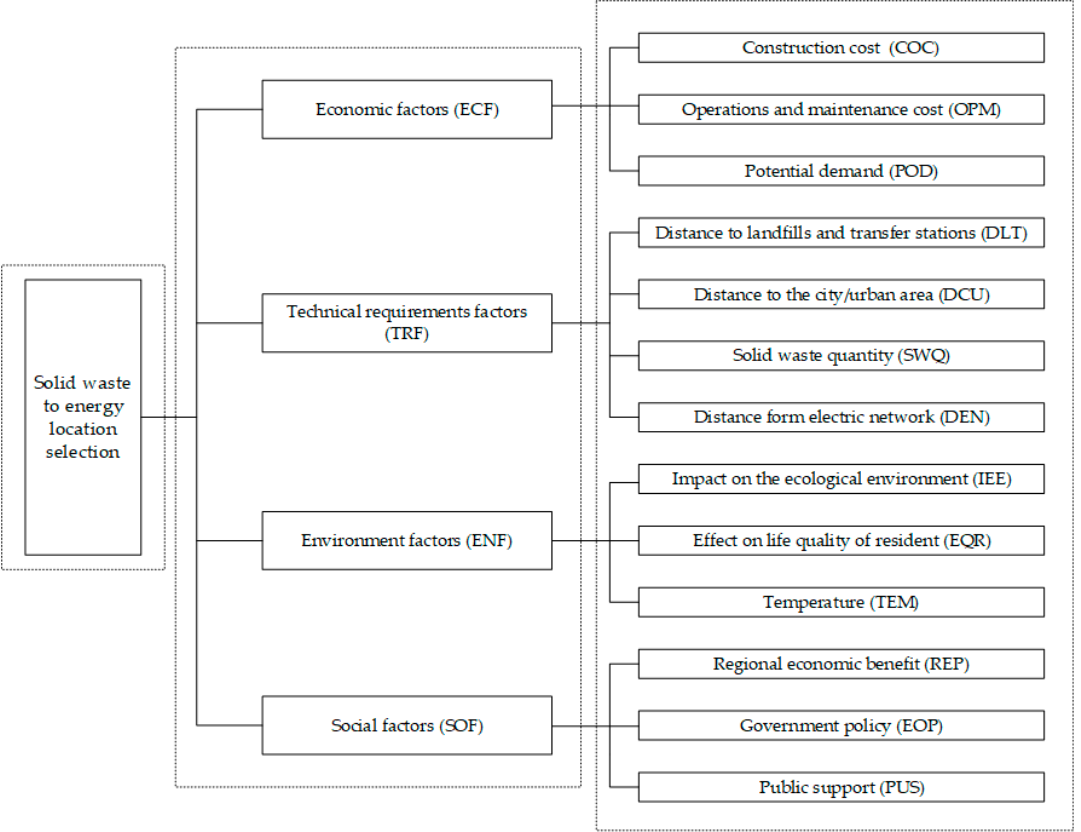
Figure 7. The hierarchical structures of the fuzzy analysis network process (FANP). A fuzzy comparison matrix for all criteria from FANP model is shown in Table 6.